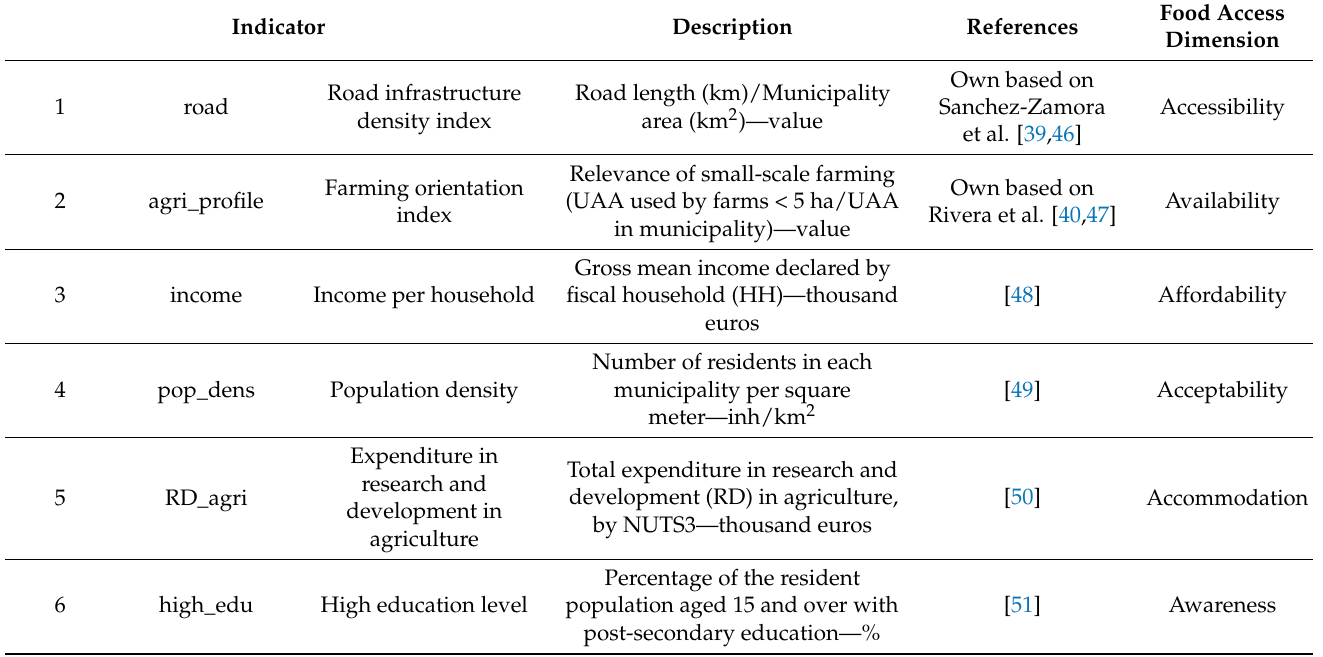
Table 1. The socio-economic and political indicators considered in this study (municipal level); our own